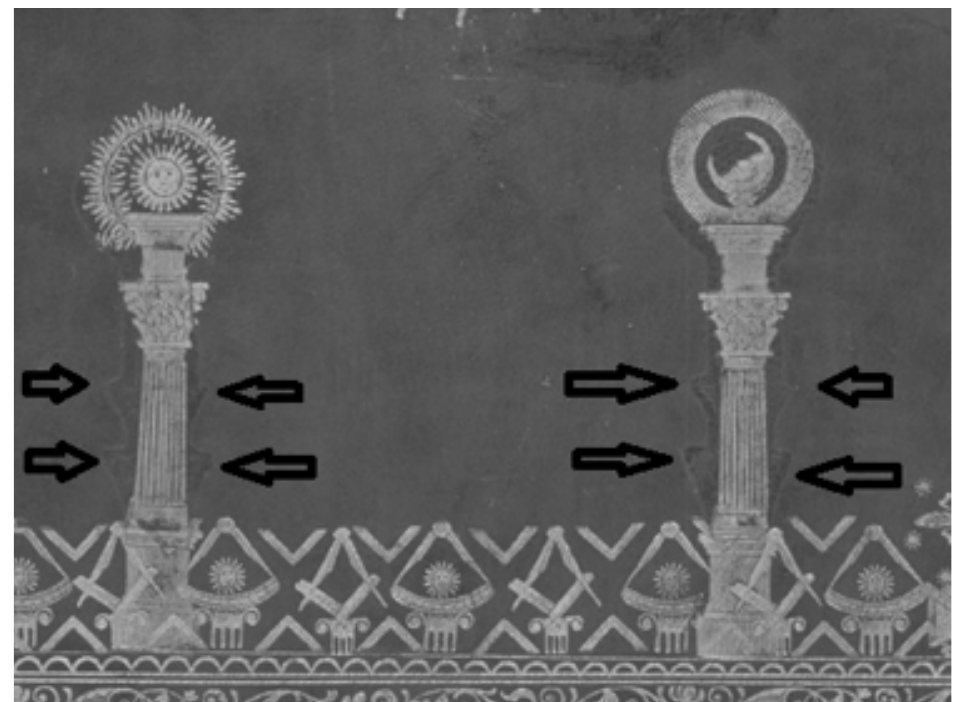
Fig. 31b. The Constitutions of the ... Masons (London, 1767-1776). Lower cover. The zigzag shape outlines on the lower parts of the columns indicate the placing of the patches. BL, C.46.h.12.